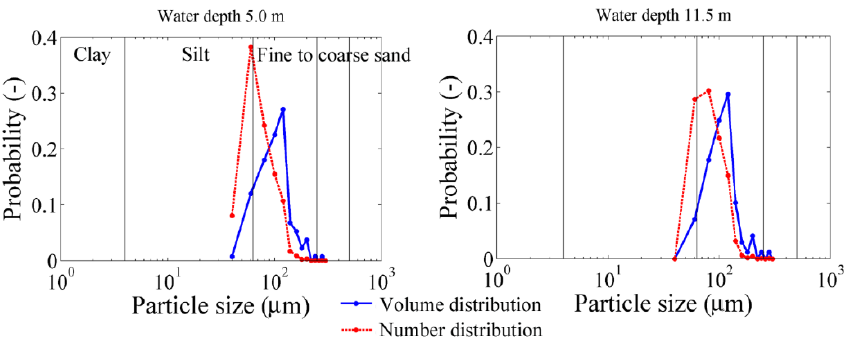
Figure 7. Subset of two PSDs from analysis of sediment suspended from the riverbed: depth-averaged samples of two verticals with different water depths in the main channel of the Parana River at Rosario bifurcation.